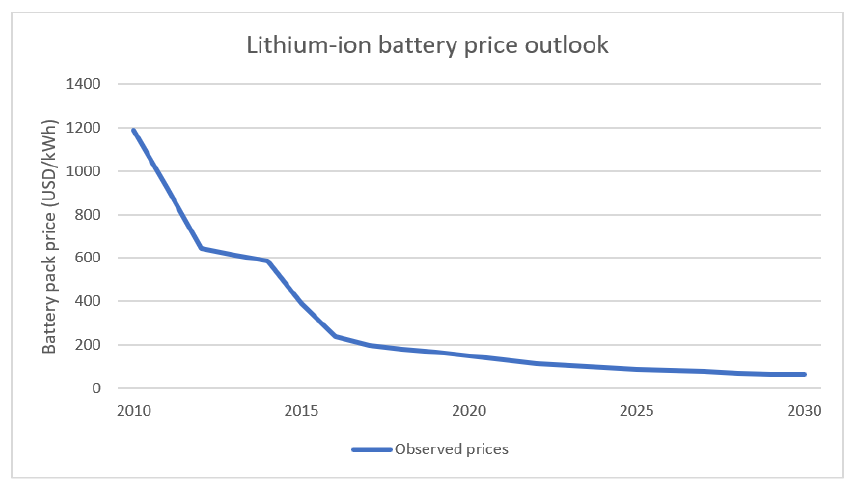
Figure 2. Development of the price of lithium batteries and the expected price outlook for the next years [18].